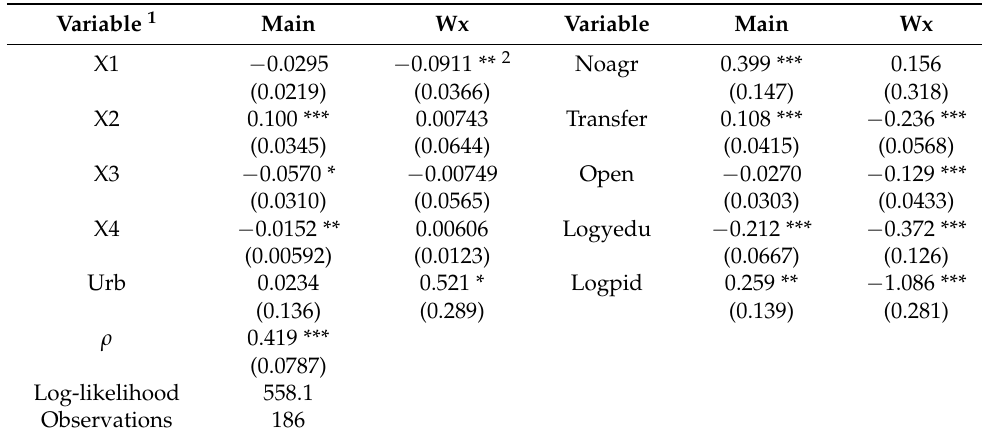
Table 6. Results of SDM estimation with spatial fixed